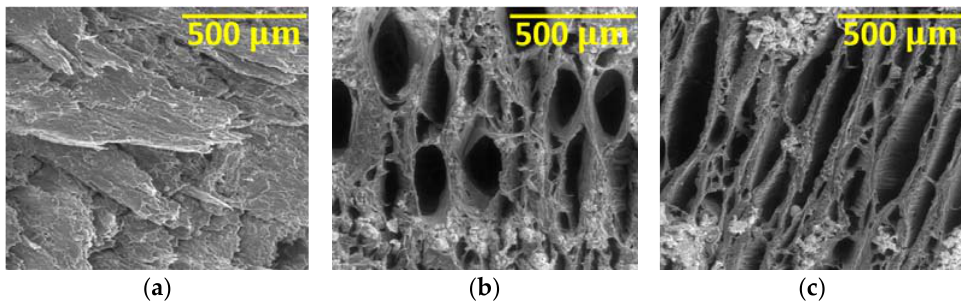
Figure 10. SEM image of the oak sample at a magnification of 200x: ( a ) before immersion, ( b ) after three weeks, ( c ) after three